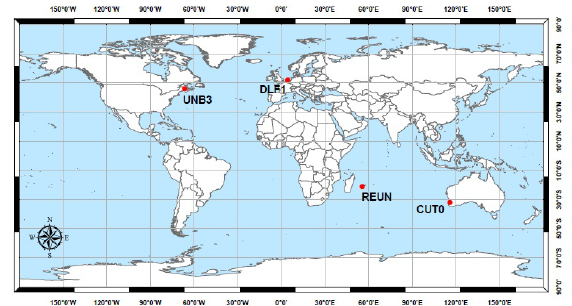
Figure 1: Analysis stations.